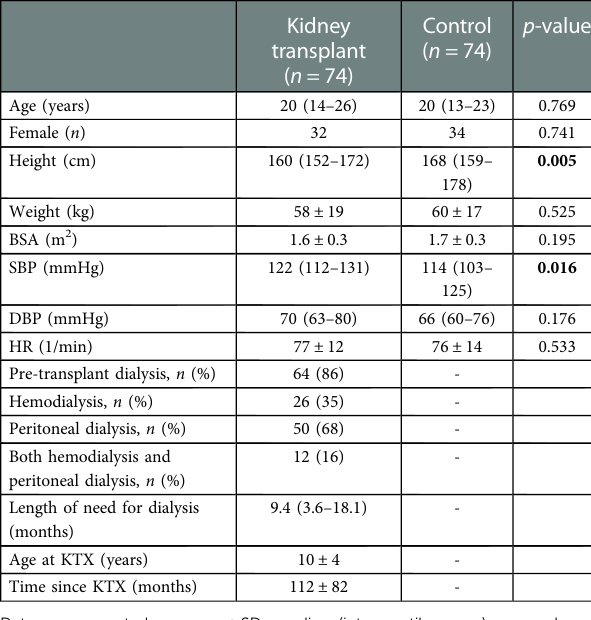
TABLE 2 Conventional echocardiographic left- and right heart parameters in the kidney transplant and the control